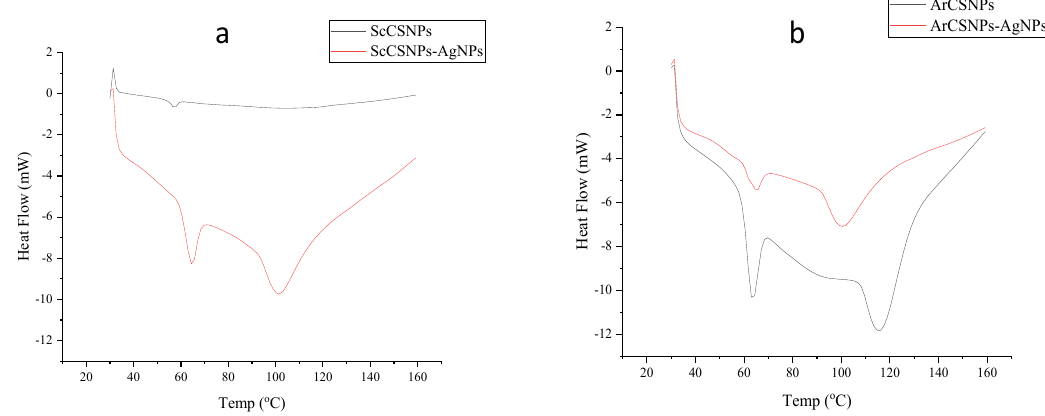
Figure 4: Differential Scanning Calorimetry thermogram of (a) ScCSNPs and ScCSNPs-AgNPs (b) ArCSNPS and ArCSNPS-AgNPs